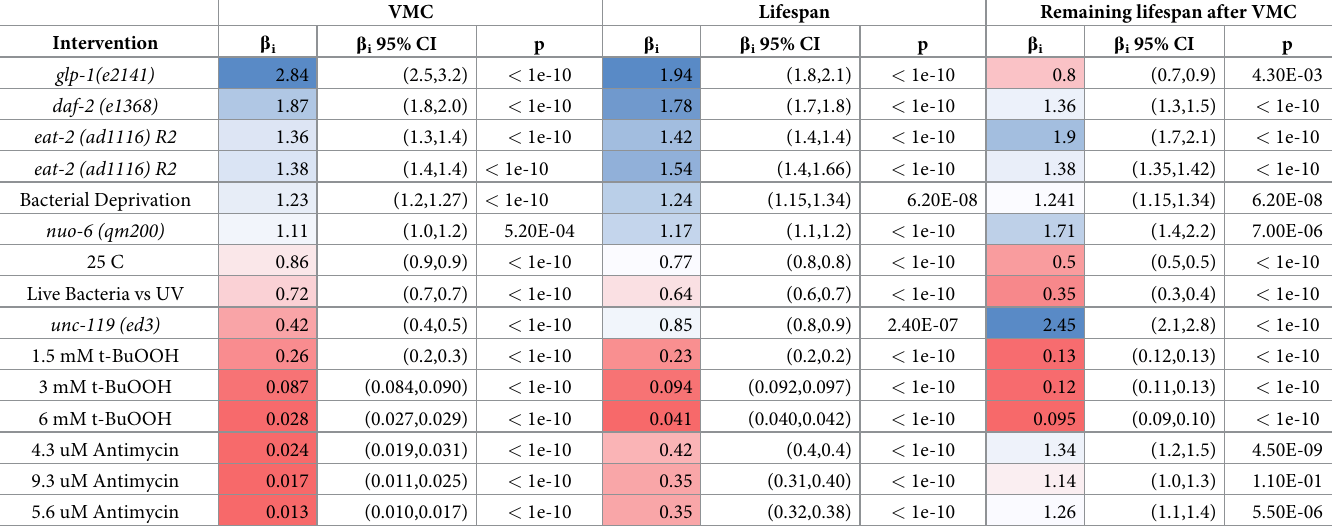
Table 2. The effect of interventions and mutations on VMC, lifespan, and lifespan remaining after VMC. β i is estimated effect size of each intervention on the three different periods of life, estimated using an Accelerated Failure Model (Statistical Methods). Cells are colored according to the effect size, blue indicating a lengthening of the period of life and red indicating a